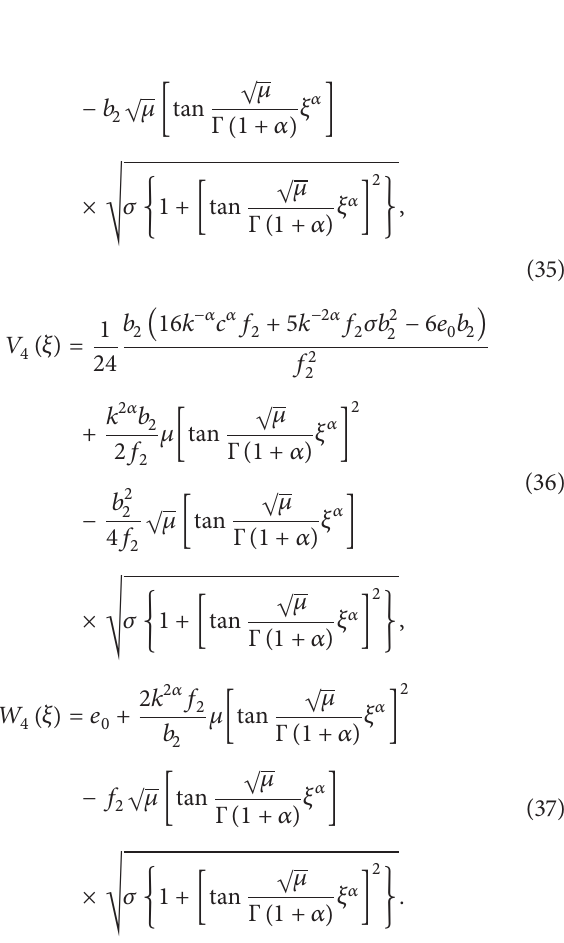
Figure 1: The solution 𝑈 3 in (32) with 𝛾 = 4/5 , 𝑘 = 𝑐 = 𝜎 = 𝑏 2 = 1 , = 0 . 𝜇 = −1 , 𝜉 0